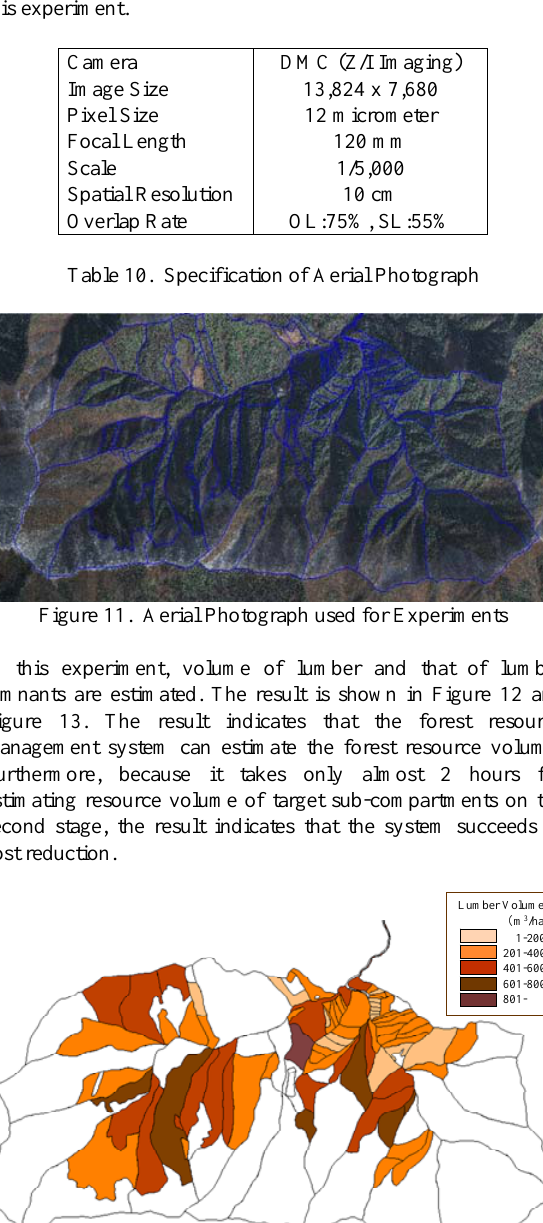
Figure 12. Result Map of Lumber